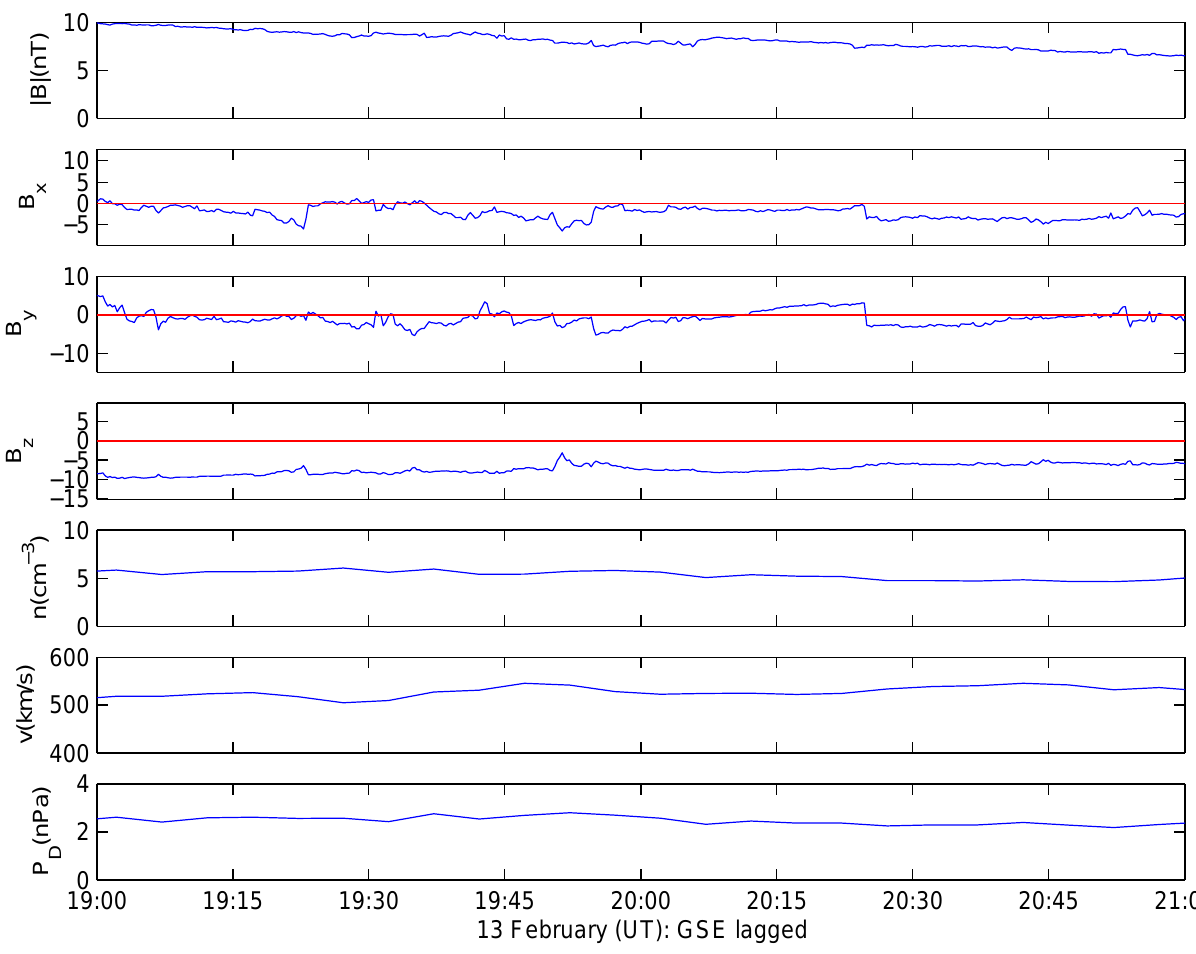
Fig. 3. Lagged solar wind data from the ACE spacecraft for the interval 19:00–21:00UT on 13 February 2001. The six panels show | B | , B x , B y and B z (in GSE coordinates), n, V and the dynamic pressure. A constant lag velocity of 530km/s and lag time of 42min was used.